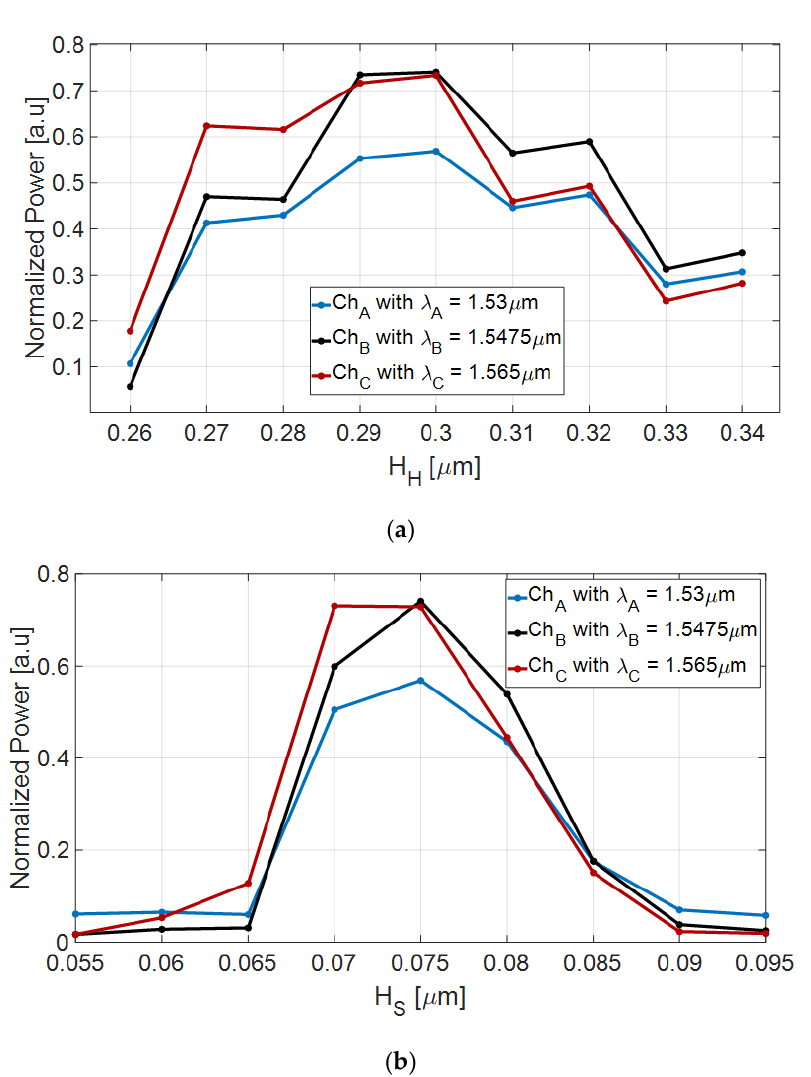
Figure 10. Normalized power at the output tapers as a function of the slot waveguide thickness. ( a ) H H and ( b ) H S .